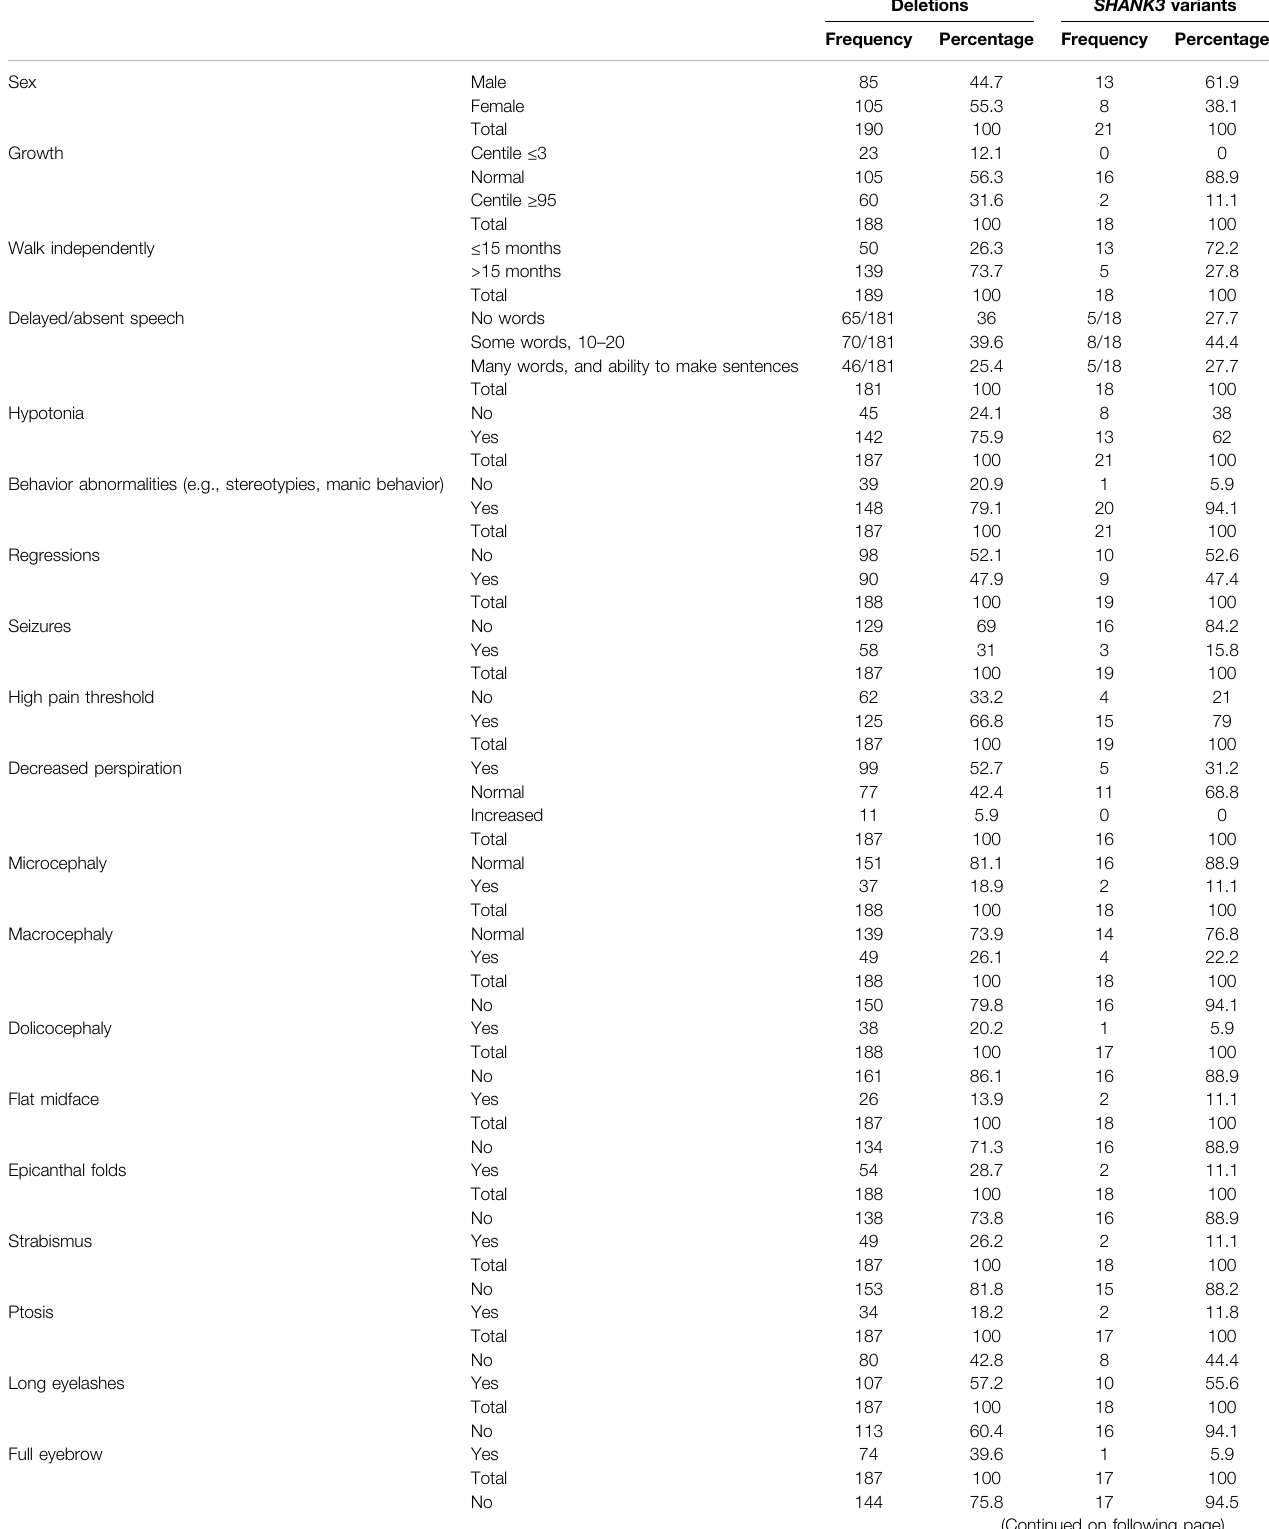
TABLE 1 | Descriptive statistics and frequencies of variables used in the study of 22q13.3 microdeletions and SHANK3 variants. a) Categorical